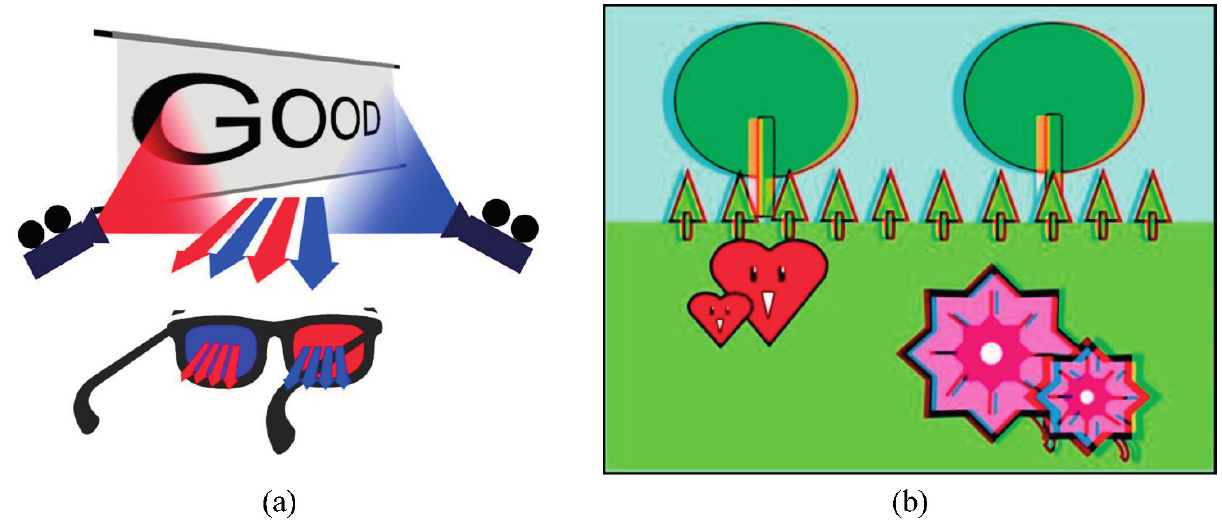
Figure 3. Classification by color-code: ( a ) red and cyan and ( b ) red and green anaglyph 3D glasses used to create 3D stereo